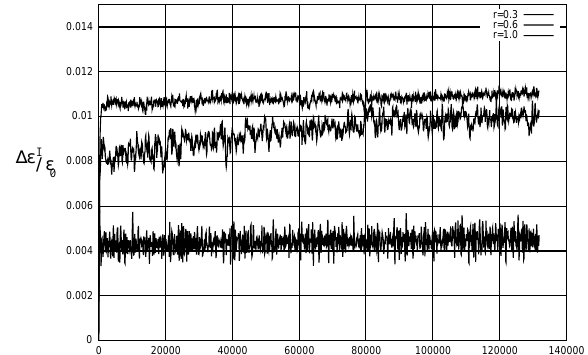
FIG. 7. Irreversible emittance growth De I (cid:1) e 0 (vertical axis) as a function of time (horizontal axis, time in turns) for three different current ratios, r (cid:1) 0.3 , r (cid:1) 0.6 , and r (cid:1) 1 . The beams are perturbed by an initial offset of d (cid:1) 0.2 (in units of s ). For r # 0.6 the frequency of the p mode lies in the continuum, and, thus, the mode is Landau damped, and the intrinsic emittance grows until the p -mode energy has been fully absorbed. For r (cid:1) 1 the p mode is not Landau damped and carries part of the kick energy. The emittance growth is significantly